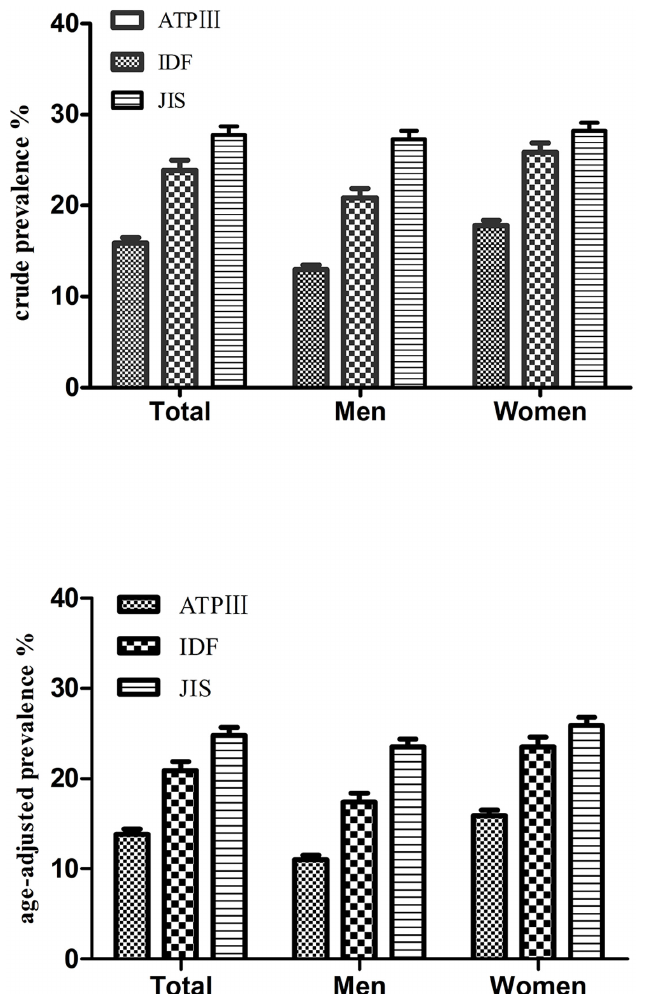
Fig 1. Crude and age-adjusted prevalence of MetS based on three diagnostic criteria in Kazakhs.